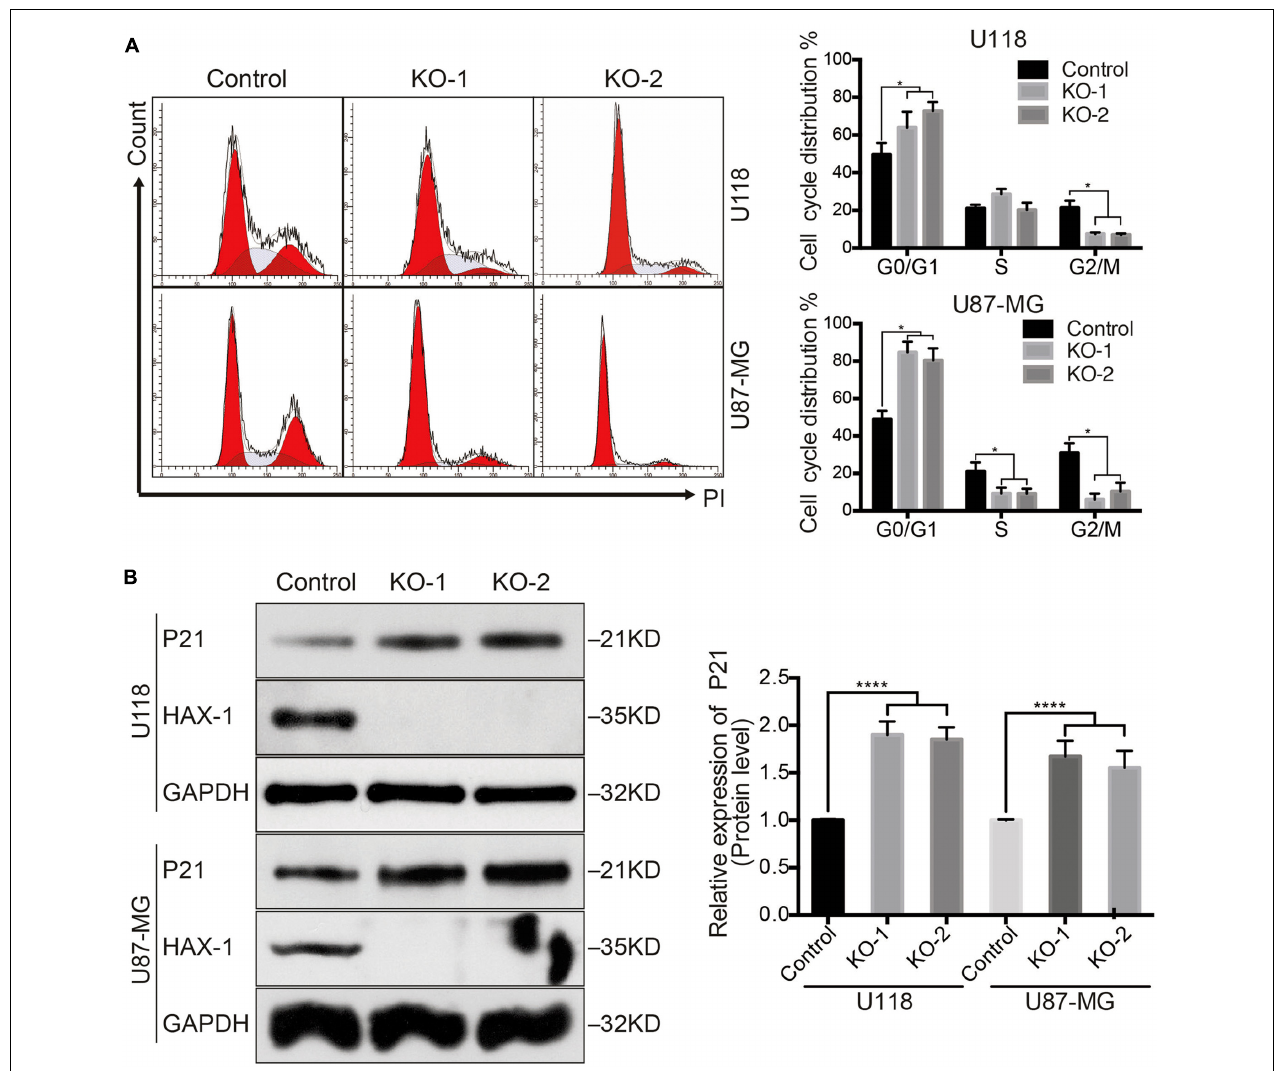
FIGURE 2 | Knock out HAX-1 induced cell cycle arrest in glioblastoma cell lines. (A) Cell cycle assays showed in both groups of HAX-1 knock-out cells (U87-MG and U118) that KO-1 cells arrest in G0/G1 phase, and in U118 KO-2 cells mainly arrest in S phase (the first red peak corresponds to the G0/G1 phase, the second red peak corresponds to the G2/M phase, and the gray are area represents S phase). (B) Western blot indicated protein p21 was overexpressed after HAX-1 was knocked-out. GAPDH was used as a loading control. Three individual experiments were performed for each group. ∗∗∗∗ P < 0.0001.